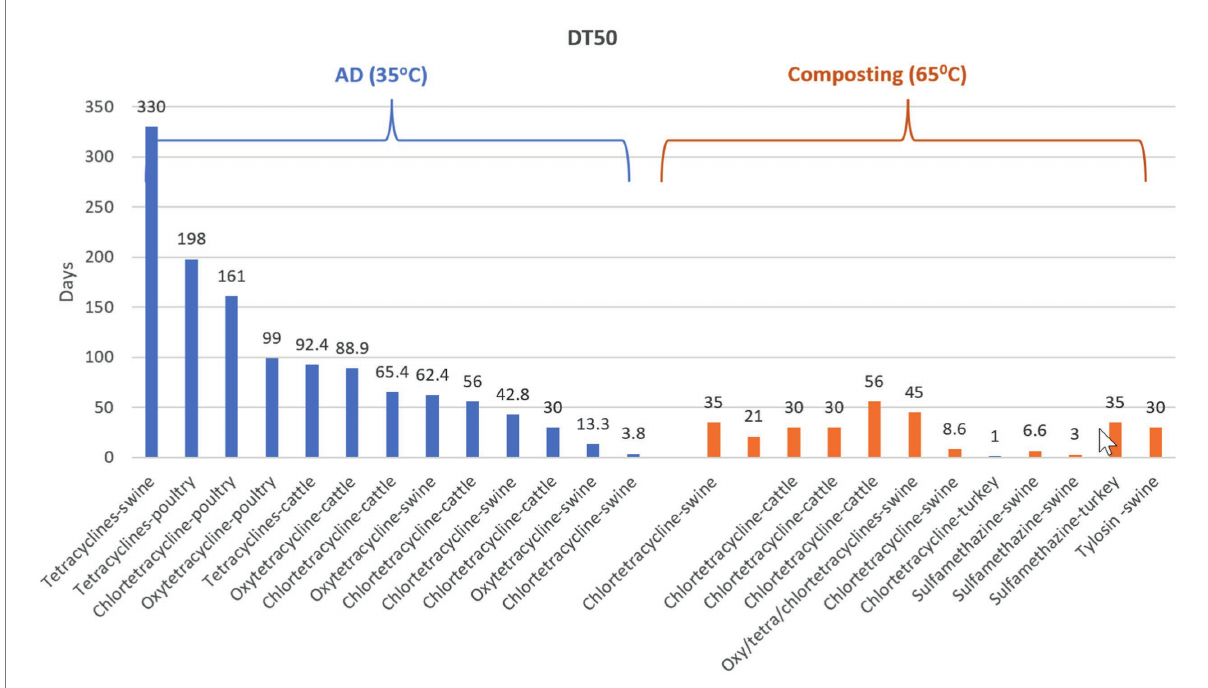
FIGURE 6 Comparative representation of the DT50 of different antibiotics during AD and composting of different types of manure (poultry, swine, cattle, turkey), reported in different studies (Osman et al., 2006; Dolliver et al., 2008; Alvarez et al., 2010; Hu et al., 2011; Kim et al., 2012; Selvam et al., 2012; Ray et al., 2017; Kasumba et al., 2020; Lee et al., 2020). The figure is created using